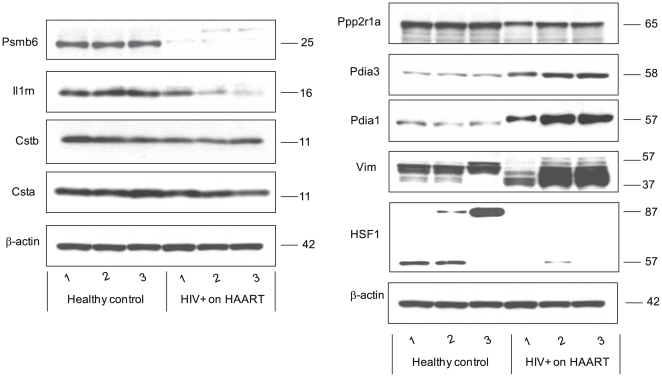
Protein abundance for representative proteins assayed by immunoblotting.Twenty micrograms of HIV-negative healthy control and HIV-infected on HAART subjects protein extracts was loaded per lane, each lane representing one of the three replicates per experimental group. The resulting blots were probed with antibodies that are specific to:- Ppp2ra1, PDIA3, PDIA1, Vim, PSMb6, IL1RN, CSTA, CSTB, and HSF1, as well as β-actin as a loading control. Relative -fold changes for these proteins in HIV-infected on HAART subjects compared to the healthy controls are given in Table 3. N1_3, healthy controls; H1_3, HIV-infected on HAART subjects (Table S1, subjects 5–7).